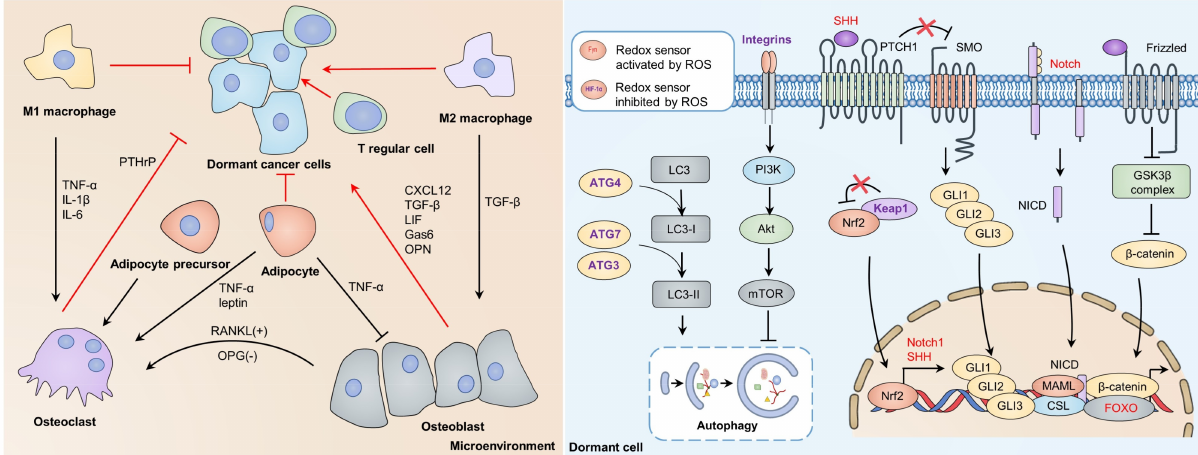
Figure 3. Dormant-dependent microenvironment and intrinsic supportive signaling. Interactions between immune cells and cytokines balance the entrance and escape of dormancy. Osteoblasts, M2 macrophages, and T regular cells are considered protectors of cancer dormancy, while osteoclasts, M1 macrophage, and adipocytes may break cancer dormancy. Redox control of dormant sustaining mechanisms. Redox may activate FOXO to bind with β -catenin to promote transcription of dormancy-related genes competitively. Upon oxidative stress, KEAP1 can be inactivated and release NRF2 to translocate into the nucleus, thus promoting transcription of Notch1 and SHH. Wnt, Notch, and Hedgehog signaling may sustain cancer dormancy through transcription of stemness-related genes. Oxidative stress may activate autophagy by impairing the integrin/PI3K/Akt/mTOR axis, which impairs autophagy by inactivating ATG4, ATG7, and ATG3. FOXO, forkhead box O; KEAP1, Kelch-like ECH-associated protein 1; mTOR, mammalian target of rapamycin; NRF2, nuclear factor erythroid 2-related factor 2; PI3K, phosphoinositide 3-kinase; SHH, sonic